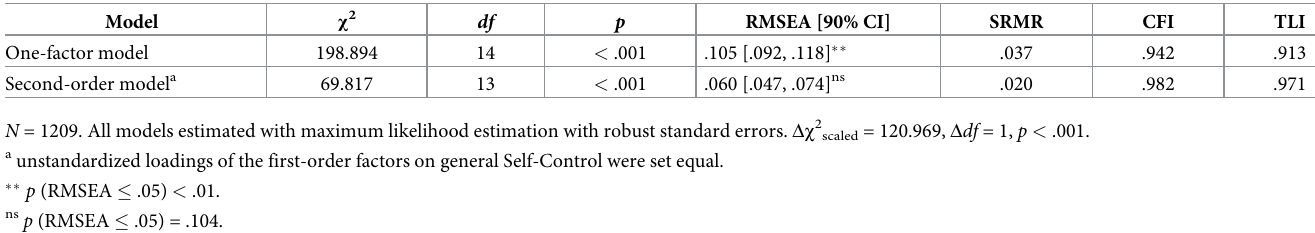
Table 1. Fit statistics for measurement models of